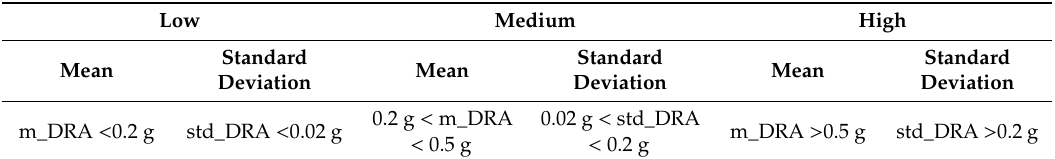
Table 2. Categorization of Detrended Resultant Acceleration (DRA) signals into low, medium, and high-amplitude signals.